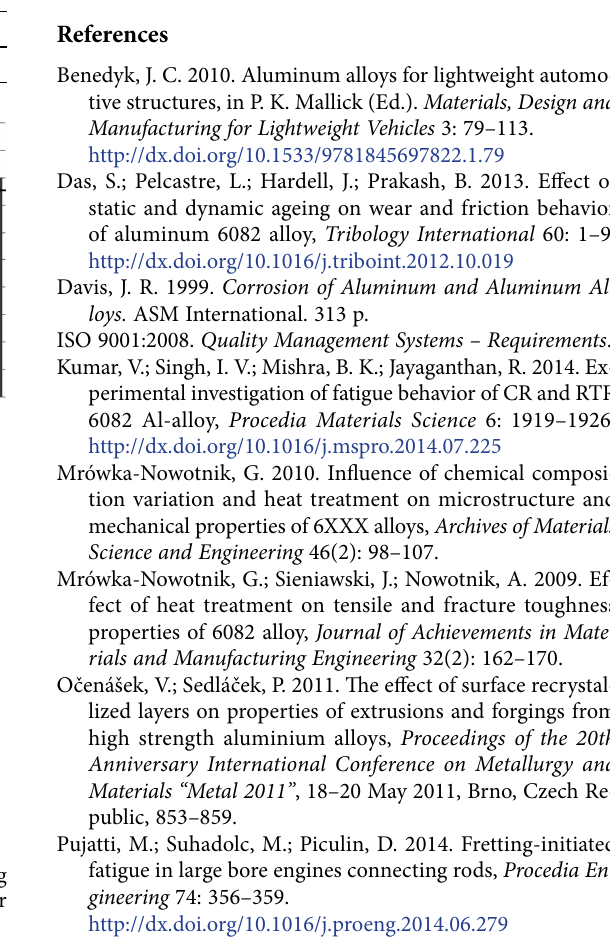
Table 4. The results of impact strength measurement Min Max Average Quantity